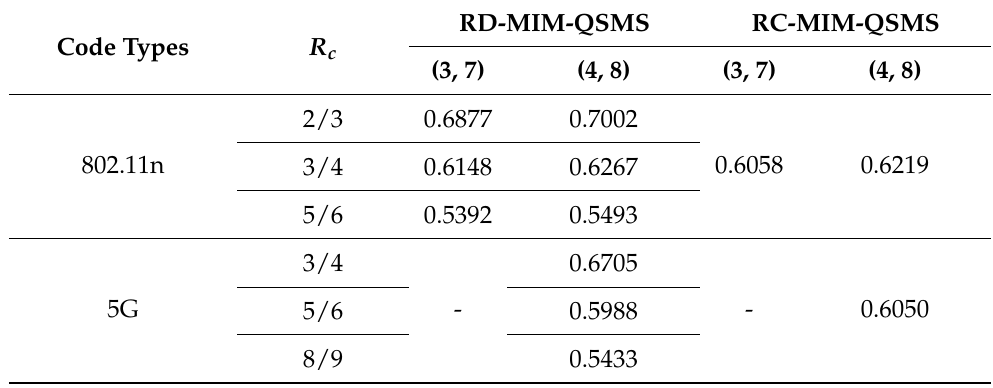
Table 2. Design Noise Standard Deviations for the RC-MIM-QSMS and RD-MIM-QSMS